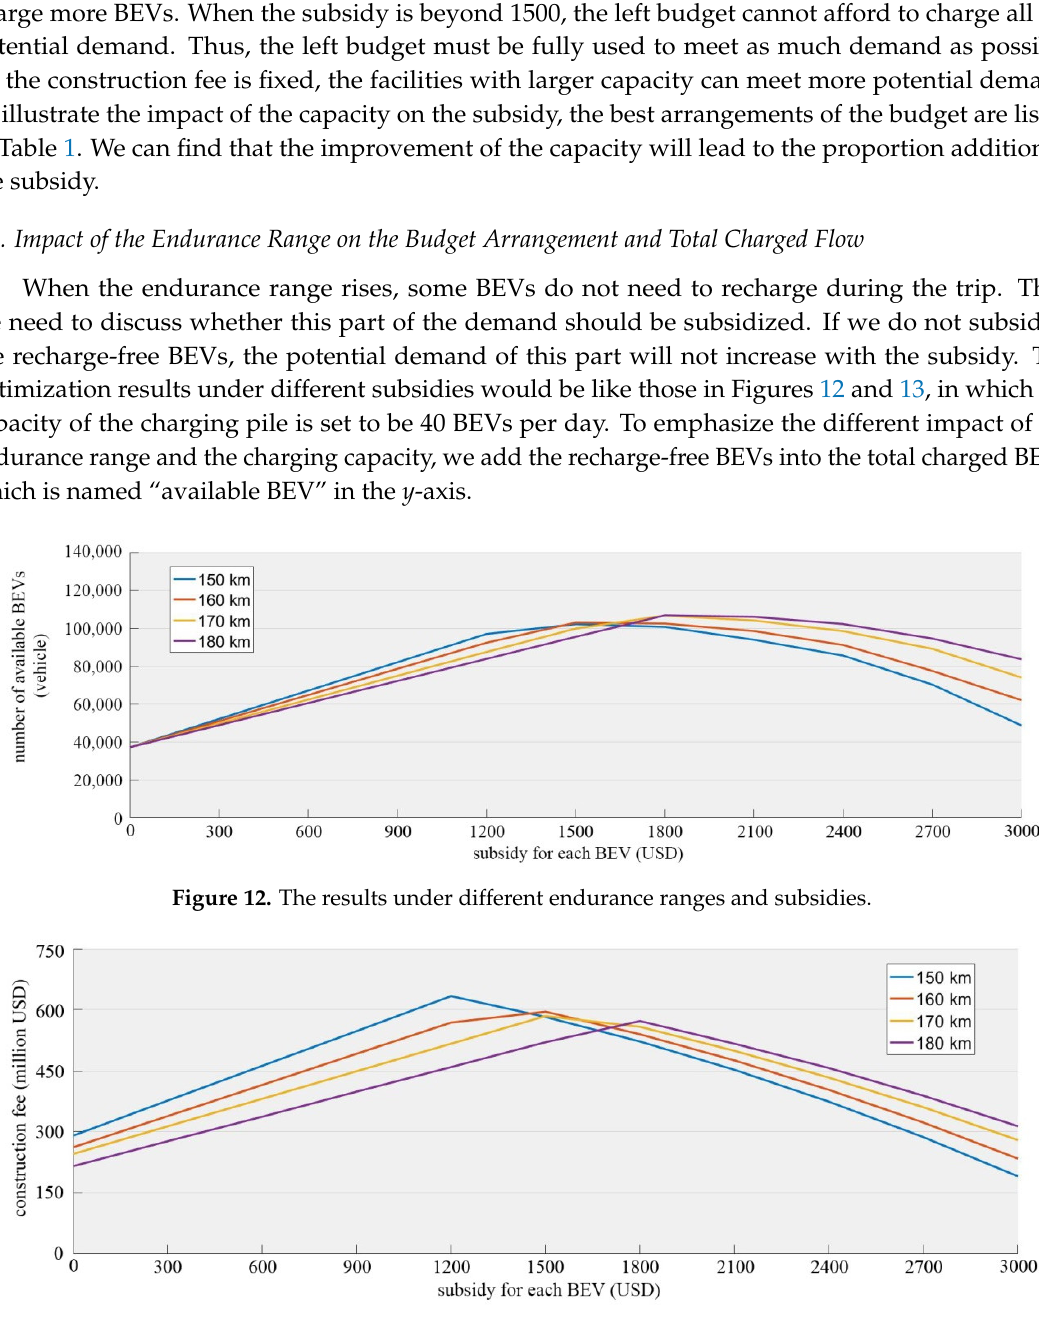
Figure 13. The total construction fees under different endurance ranges and subsidies.